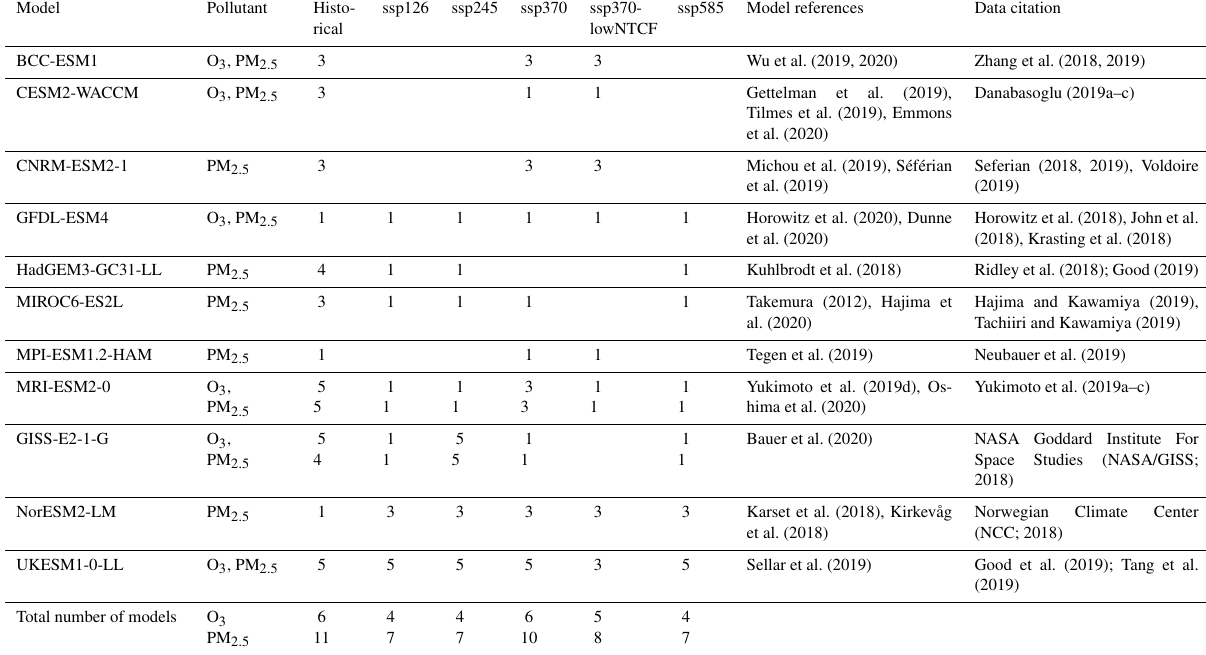
Table 1. Number of ensemble members used for the historical- and future-scenario experiments from each model in the analysis of surface O 3 and PM 2 . 5 in this